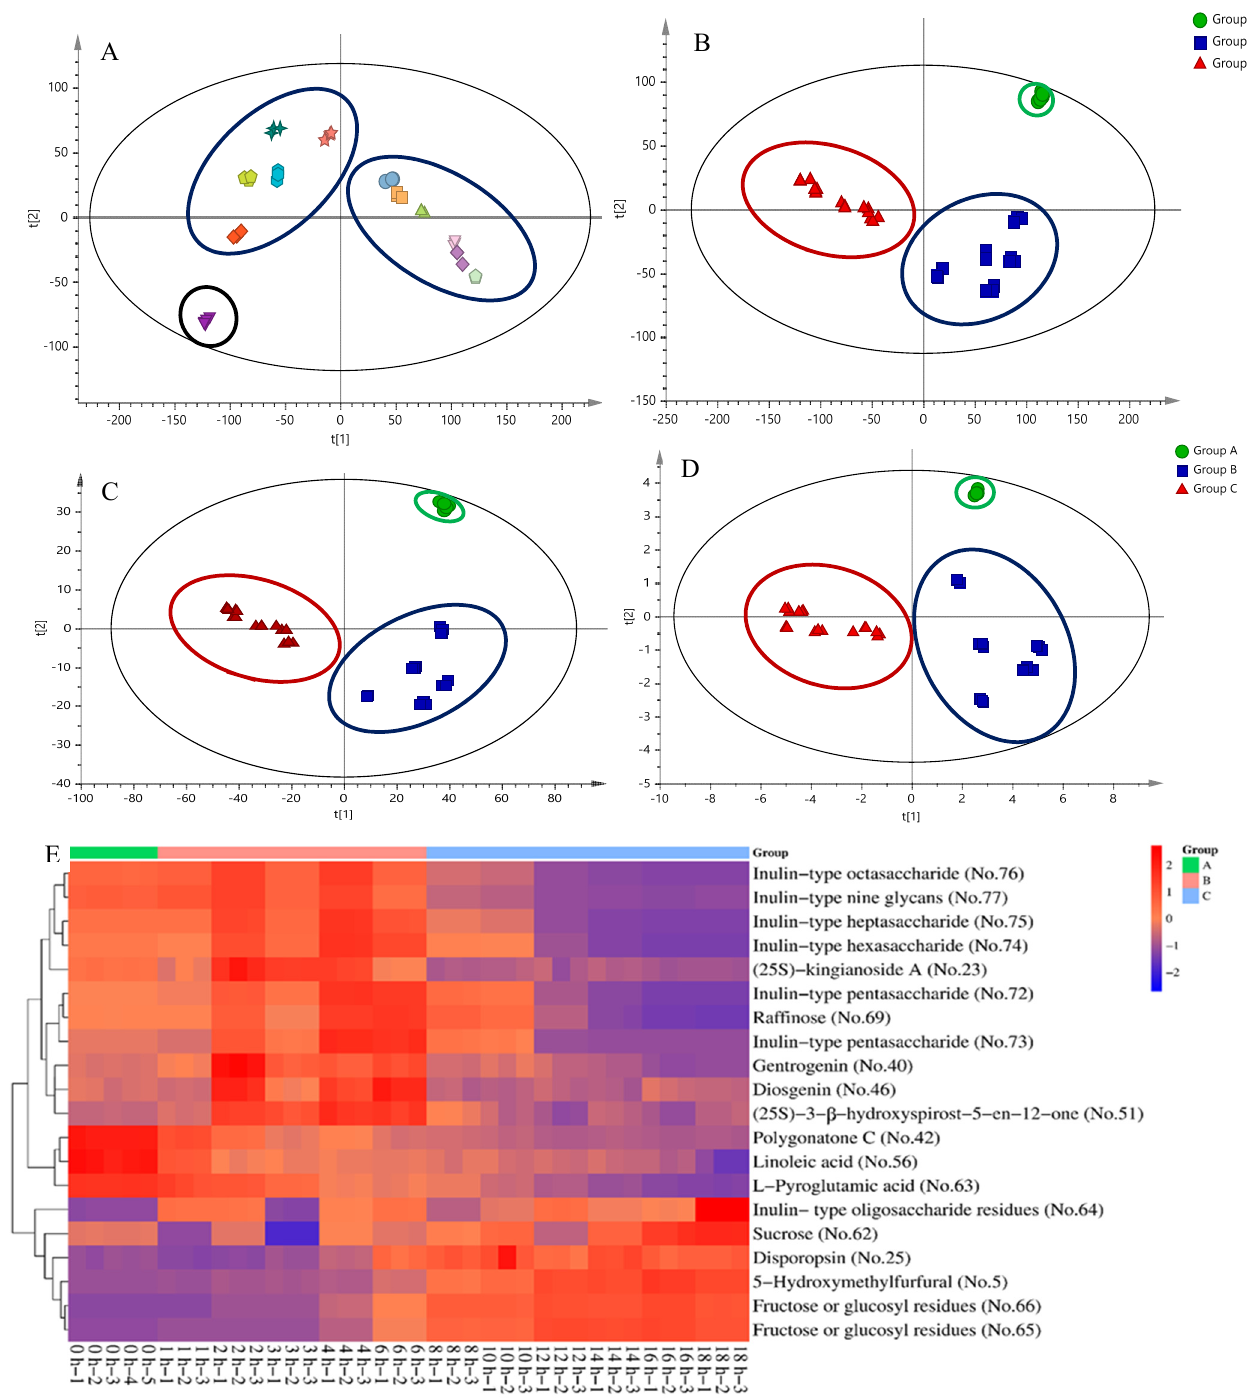
Figure 3. ( A ) PCA plot of 38 samples depending on 14,772 variables; R 2 X = 0.92, Q 2 = 0.834. ( B ) PLS-DA plot of 14,772 variables; R 2 X = 0.79, R 2 Y = 0.996, Q 2 = 0.989. ( C ) PLS-DA plot of 1846 variables; R 2 X = 0.864, R 2 Y = 0.991, Q 2 = 0.980. ( D ) PLS-DA plot of 20 differential markers; R 2 X = 0.886, R 2 Y = 0.920, Q 2 = 0.911. ( E ) Heat map of 20 differential markers. Raw PCR, PCR processed for 1–6 h and PCR processed for 8–18 h were clustered into groups A, B, and C, respectively.